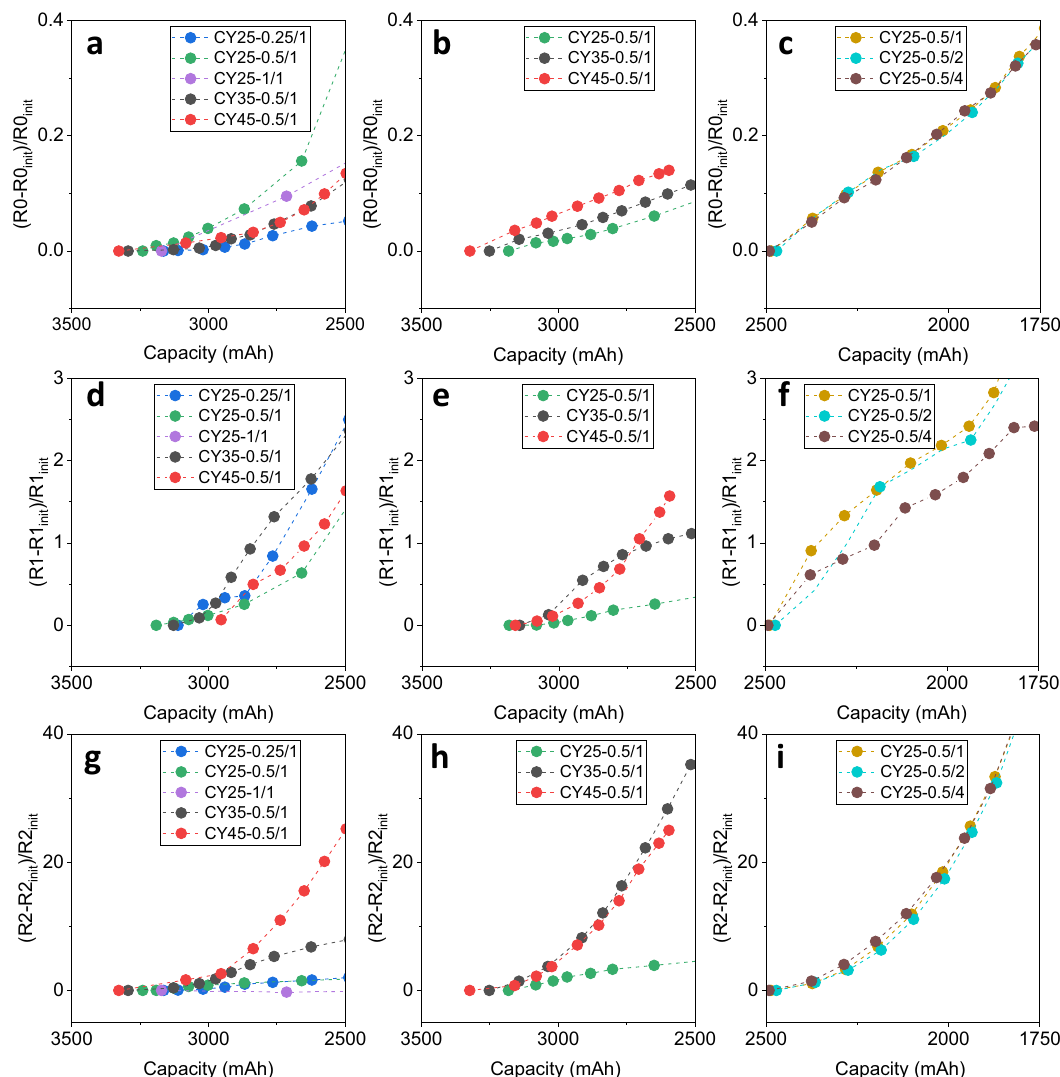
Fig. 5 AC electrochemical impedance variations of the lithium-ion cells during cycling. The resistance increment from the initial value ( R init ) is calculated for comparison. The ohmic resistance of NCA cells ( a ), NCM cells ( b ), and NCA + NCM cells ( c ). SEI resistance of NCA cells ( d ), NCM cells ( e ), and NCA + NCM cells ( f ). Charge transfer resistance of NCA cells ( g ), NCM cells ( h ), and NCA + NCM cells ( i ). Only resistances before the capacity reducing to 71% of nominal capacity are shown to be consistent with the datasets in the study. The coef fi cient of determination ( R 2 ) between the raw and fi tted impedance data is summarized in Supplementary Table 12. The SEI resistances are not identi fi ed in some cycles (seen in Supplementary Table 12) for the NCA battery ( d ) and NCM battery ( e ). The shared information of raw impedance data and fi tted data can be found in the data